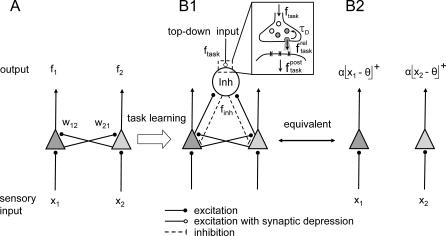
Top-Down Suppression of Recurrent Excitation in V1(A) Mutually exciting neurons in V1, each responsive to a bar within their corresponding receptive field, determine the neuronal responses shown in Figure 1B and described by Equation 1.(B1) Recurrent inhibition within V1 (finh), which is silent in the absence of top-down input, can be activated by an input from a higher cortical area (ftask). Inset: the top-down input undergoes short-term synaptic depression which normalizes the drive to the inhibitory neuron: if the presynaptic firing rate, ftask, is above some critical frequency (of roughly 25 Hz), the vesicle release rate, 
, and the effective postsynaptic rate, 
(which is the product of 
times the synaptic strength), both saturate. The synaptic strength can be tuned such that the saturation value of 
just overcomes the firing threshold, making inhibition linear in the inputs from the two pyramidal neurons (Equations 2 and 3).
(B2) As a consequence, any strong top-down input to the inhibitory neuron leads to a cancellation of the mutual excitation among the pyramidal neurons through their own drive of the recurrent inhibition. The circuitry in B1 then becomes equivalent to a decoupled V1 circuitry which feeds sensory input through, as the recurrent connections would not exist (compare Equations 4 and 5).